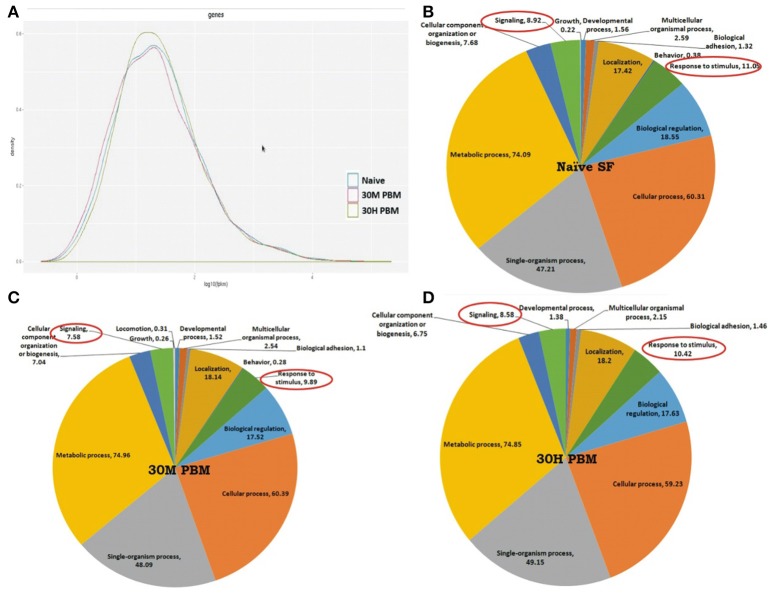
Blood meal cause modest changes in the molecular architecture of the mosquito olfactory system: (A) Read density map of the compared Naive; 30 m and 30 h post blood meal (PBM) transcriptomic data of olfactory system; (B–D) Functional annotation and molecular catalog of olfactory transcriptome (Biological Process/Level2/% Transcripts). The red circle marks the genes selected for transcriptional response monitoring. (See Text).